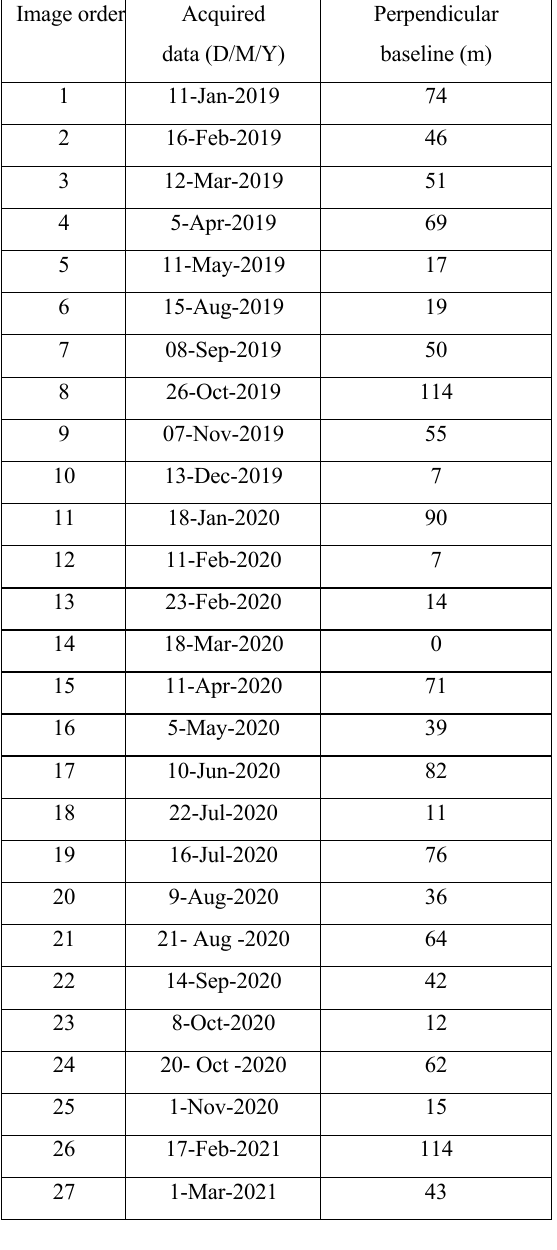
Table 1. Sentinel-1A dataset and Perpendicular Baseline data showing the perpendicular distances between slave images and the master image were selected as of March 18, 2020.